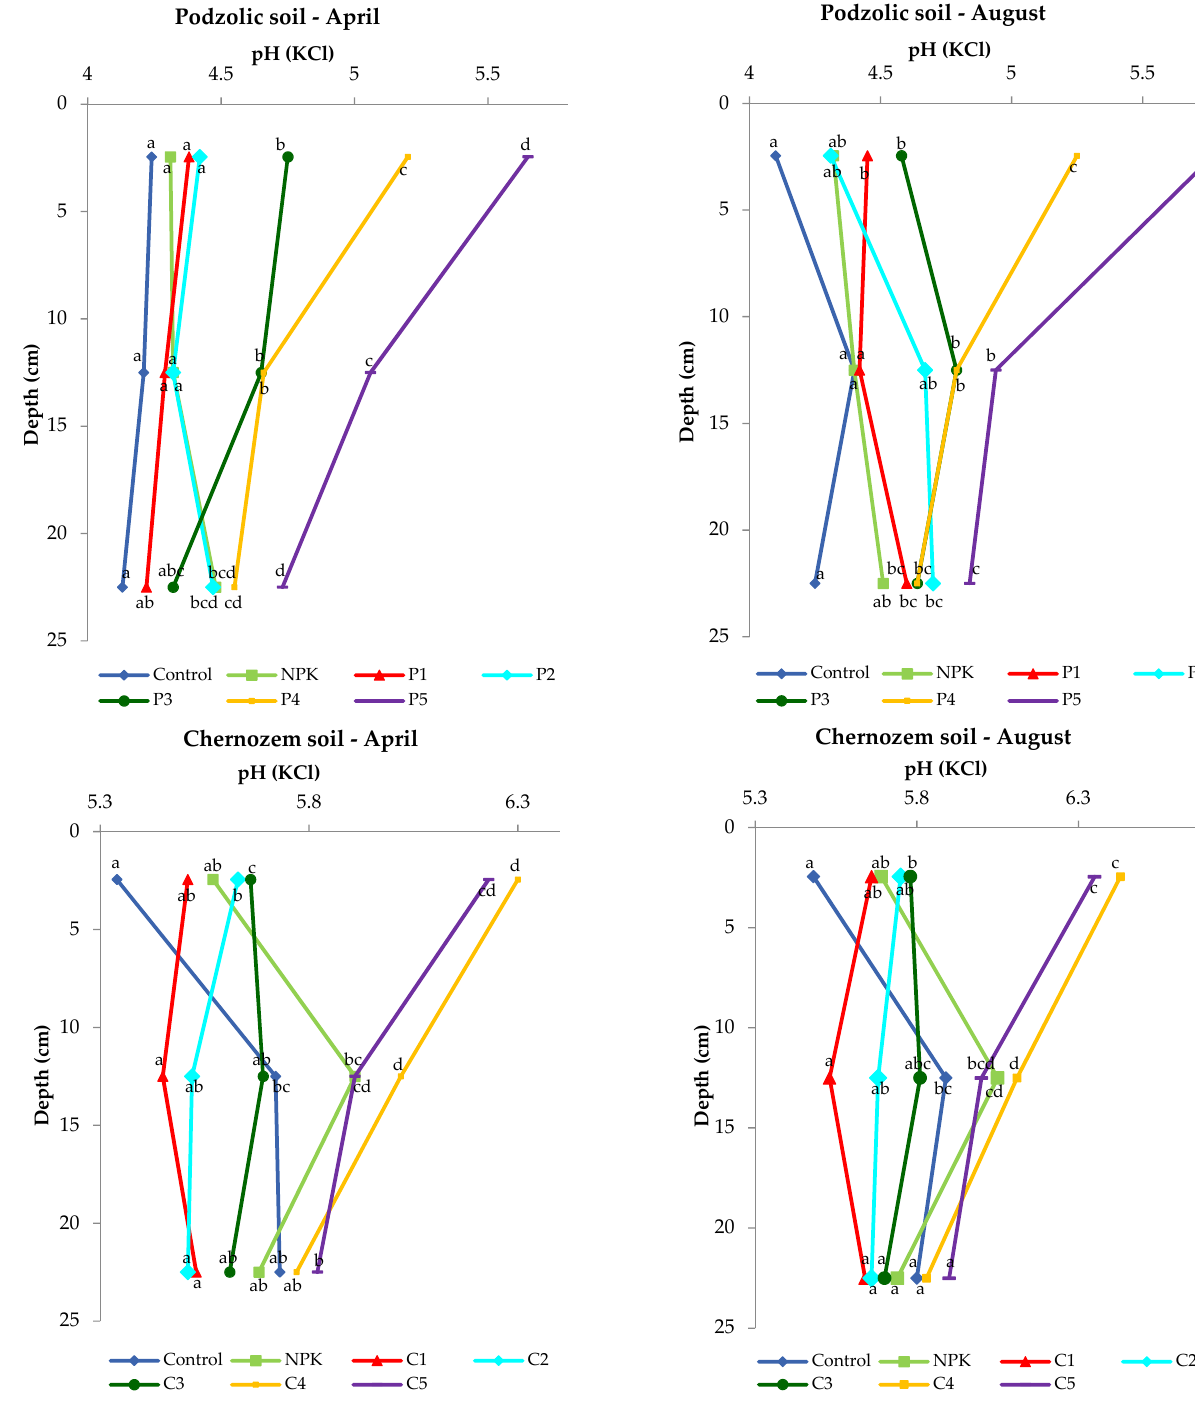
Figure 3. Differences in soil reaction upon the application of different ash doses.